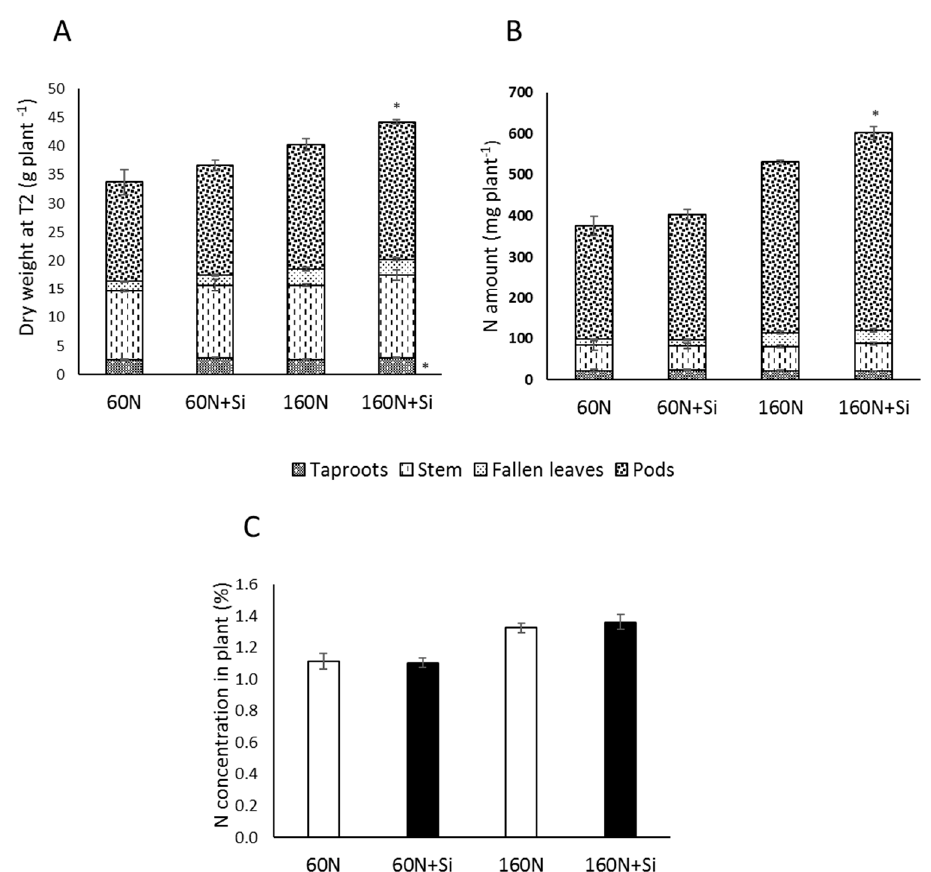
Figure 3. Compartment and total biomasses ( A ), total nitrogen amount ( B ) and N concentration ( C ) in rapeseed plants harvested at T2 (G5 stage). Plants were grown in lysimeter with 60 (60 N) or 160 kg of N ha − 1 (160 N) and supplied with or without Si (12 kg Si ha − 1 : 60 N + Si and 160 N + Si). Values correspond to the mean ± SE for n = 3. The data obtained from plants treated with silicon (60 N + Si and 160 N + Si) were compared to their respective control. * indicates a significant difference at p ≤ 0.05.